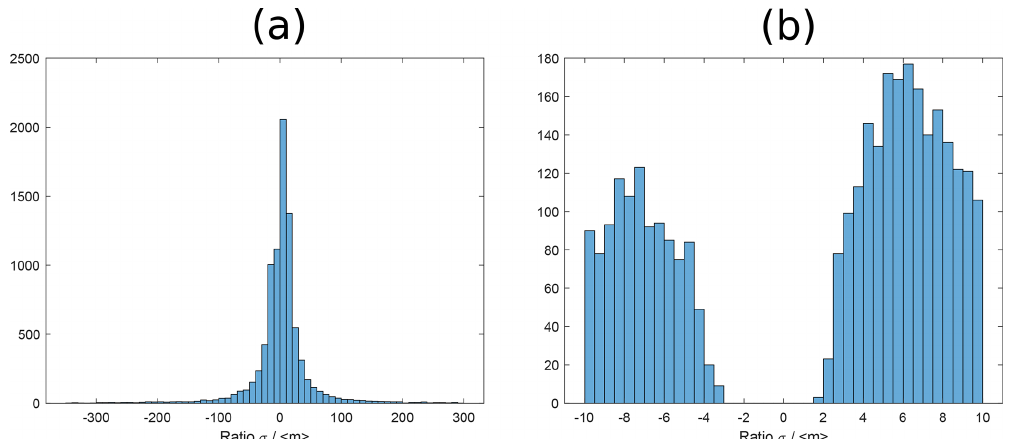
Figure 6. Histograms of the ratio between standard deviation σ and average value < m > of the measurement deviation in the sphere centre-to- centre distances. The standard deviation and average are calculated per sphere pair over all 50 different phase angle sets (compare Sect. 4.2). For these histograms, the signed values of the measurement deviations are used. The left histogram (a) shows the range between the 1st and the 99th percentile, and the right histogram (b) shows the centre in detail. The histograms show that the different phase angles have a substantial impact on the measurement deviation and that there is no meaningful “average deviation” for all phase angles (from which the selection of a specific set of phase angles would only induce a small perturbation).